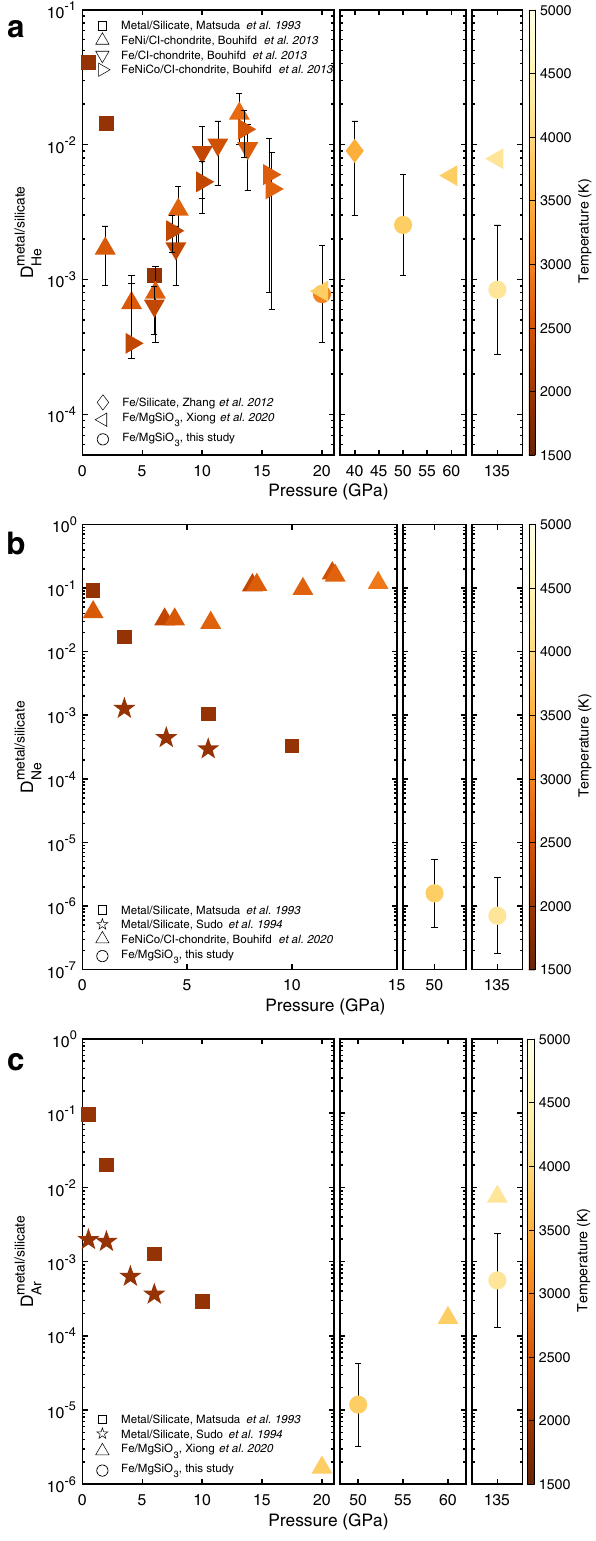
Fig. 1 He, Ne and Ar partition coef fi cients. Calculated and literature partition coef fi cients (concentration in weight) between liquid Fe and silicate melt at different pressures and temperatures for ( a ) He, ( b ) Ne and ( c ) Ar. a Helium shows some variation in D with pressure depending on the particular study, however these changes are relatively small in comparison with the other noble gases (note different scale) and all results are consistent with a D between 10 − 3 and 10 − 2 . b There are some differences between different experimental studies for Ne at low pressure, with the more recent experiments of Bouhifd et al. 31 showing an almost constant D across all pressures. In contrast our results agree better with the earlier experiments and we predict very low D s for Ne at high pressures. c Argon shows a decrease in D until about 20 to 50 GPa followed by a strong increase. As discussed in the text, these trends can be explained by atomic size variations.